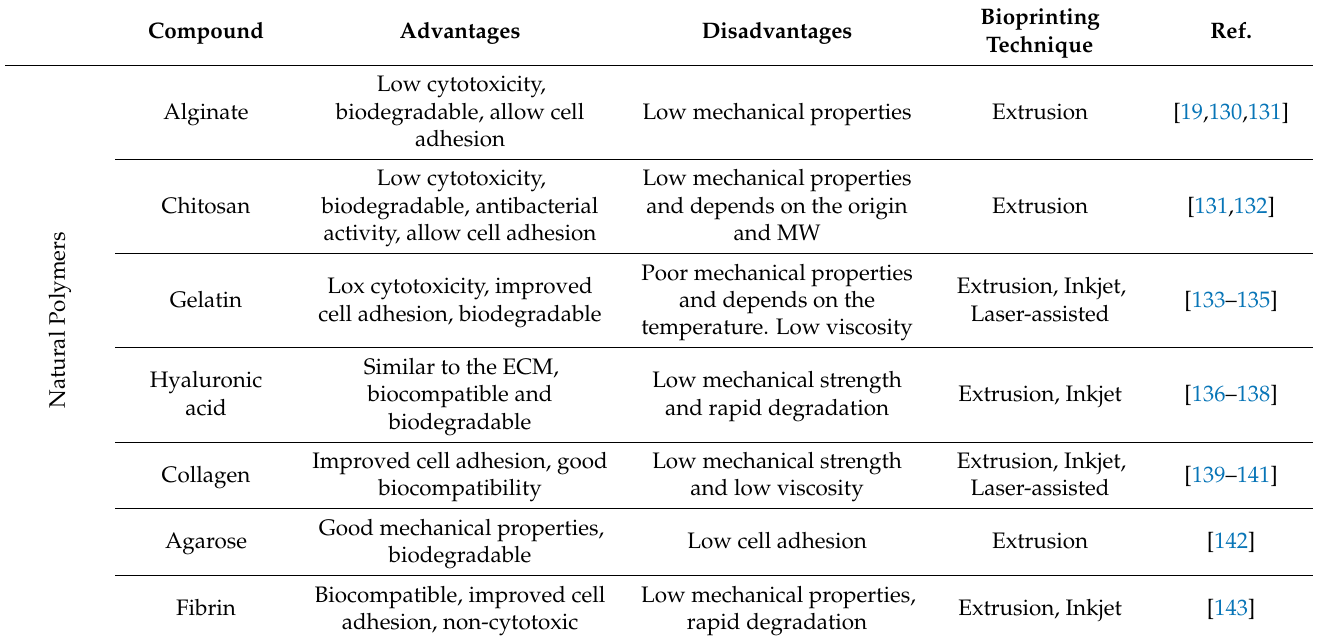
Table 2. Most common natural polymers used for the preparation of bioinks.